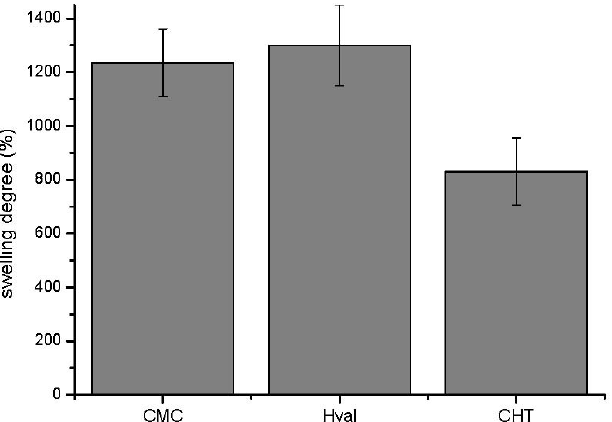
Figure 4. Swelling degree of different squeezed polysaccharide-based hydrogels in 0.1 M NaCl solution at pH 7.4. Data are reported as mean of three values  standard